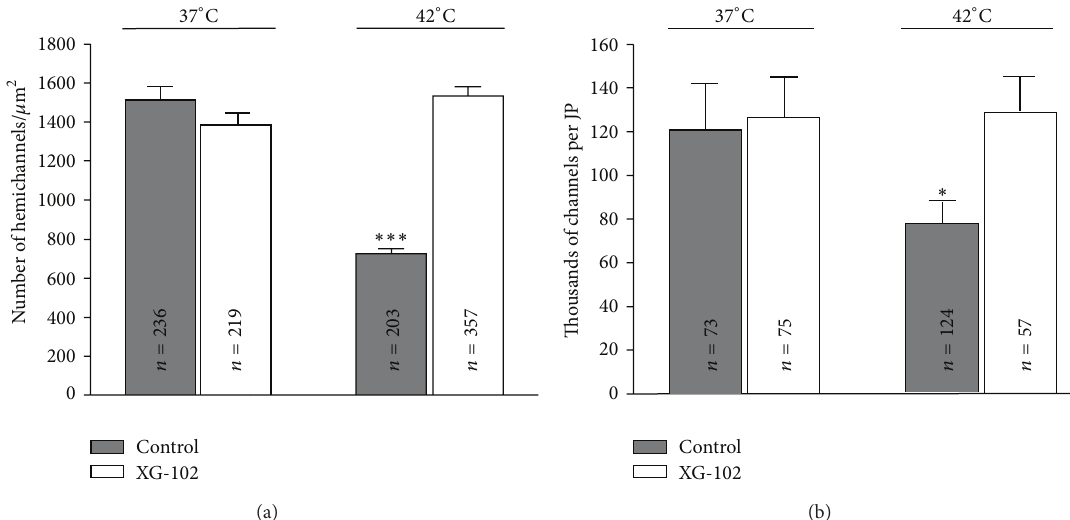
Figure 5: The effect of hyperthermia on the hemichannel density in Cx43-EGFP HeLa cell membranes (a) and number of channels in the JPs (b) in the absence and presence of JNK inhibitor XG-102 (4 𝜇 M). 𝑛 is indicated on the respective bar; ∗ = 𝑃 < 0.05 ; ∗∗∗ = 𝑃 < 0.005 , ANOVA followed by post hoc Bonferroni’s